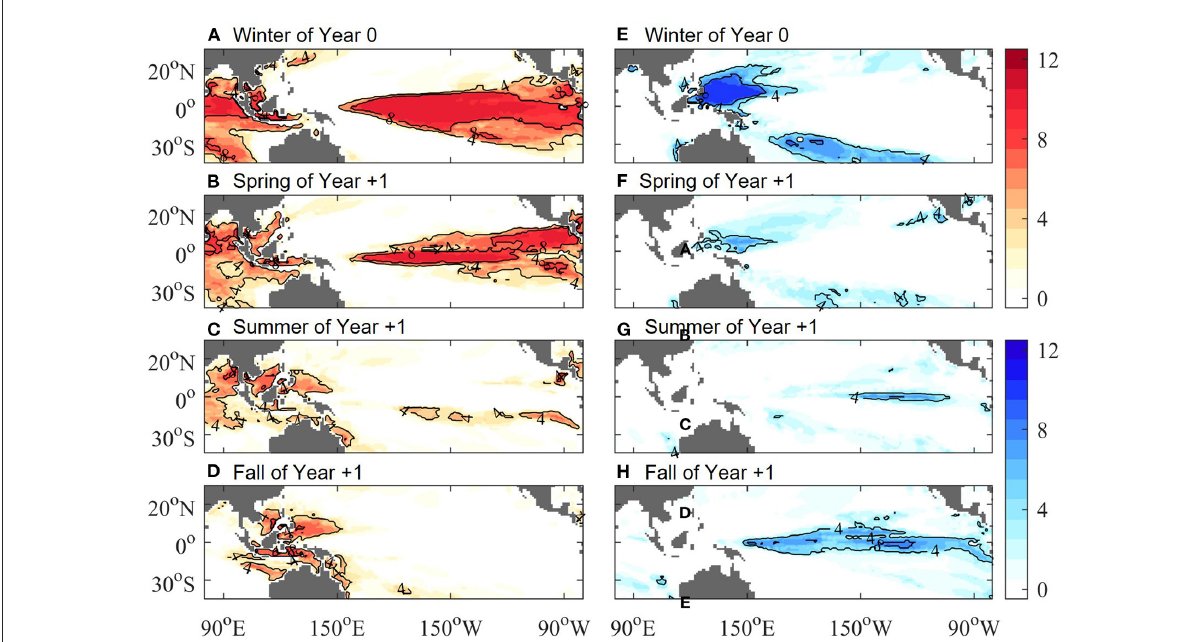
FIGURE14 Numbers of ensemble members of the CNRM-CM5 model with significant positive correlations between the WEP SZWA in fall and the tropical Indo-Pacific Oceans SSTA in (A) winter of Year + 0, (B) spring of Year + 1, (C) summer of Year + 1, and (D) fall of Year + 1. (E–H) are same as (A–D) , but for significant negative correlations.